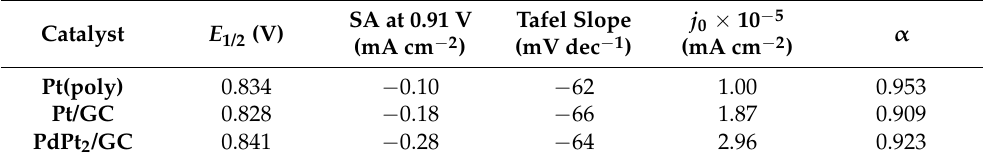
Table 3. Half-wave potential, specific activity, and kinetic parameters for ORR on Pt/GC and PdPt 2 /GC in 0.1 M NaOH solution, compared to